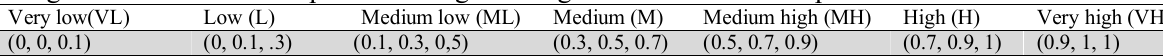
Very low(VL) Low (L) Medium low (ML) Medium (M)